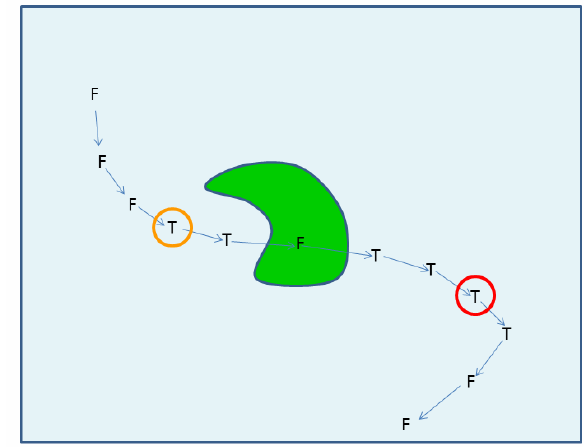
Fig. A4. Schematic illustration of the storm-track condition assess- F IG . 10. Schematic illustration of the storm-track condition assessment procedure. Each 2 ment procedure. Each clump is individually assessed and is flagged clump is individually assessed and is flagged true (T) or false (F) depending on whether it 3 true (T) or false (F) depending on whether it satisfies the clump satisfies the clump conditions. The storm-track condition specifies a minimum number of 4 conditions. The storm-track condition specifies a minimum number of consecutive true clumps. The orange and red circles indicate the consecutive true clumps. The orange and red circles indicate the storm position after 1 and 3 5 storm position after 1 and 3 consecutive true clumps consecutive true clumps respectively. 6